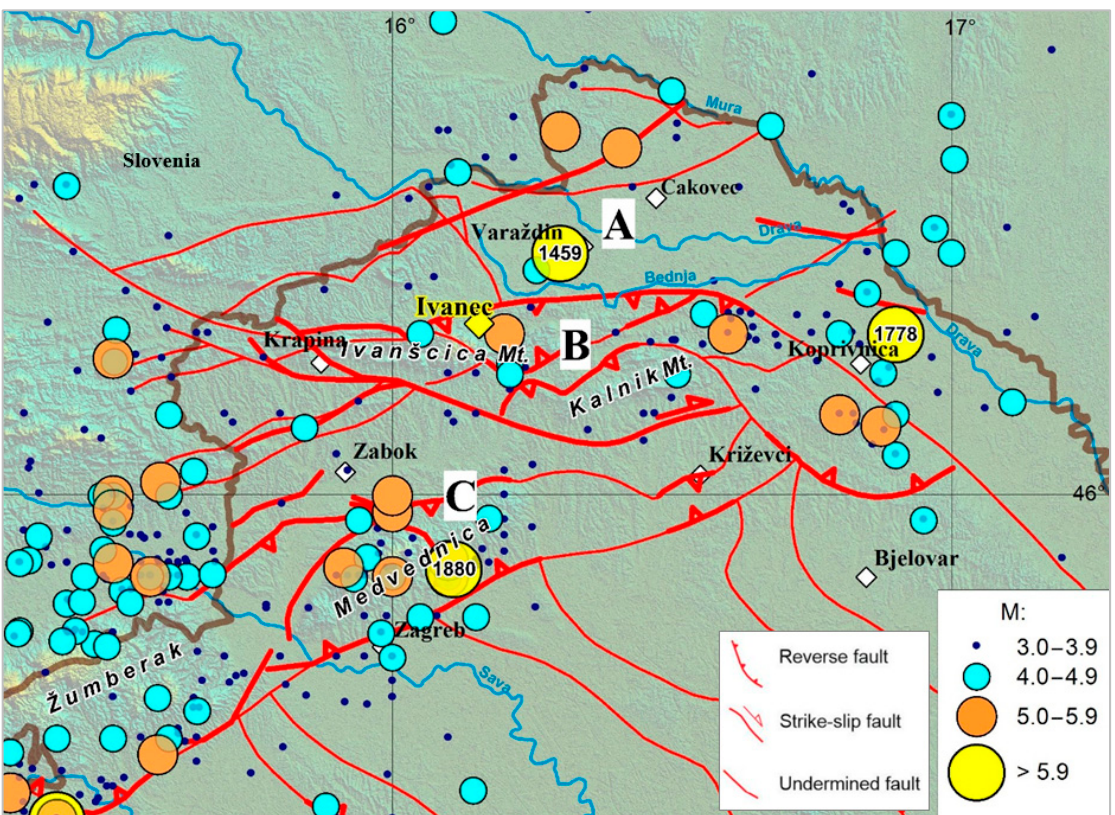
Figure 2. Epicentres of all earthquakes with M L ≥ 3.0 based on Croatian Earthquake Catalogue (373 BC to 2018) in the circle of approx. 50 km around the City of Ivanec (city location marked with yellow square). Most important seismogenic faults are shown with red lines are: (A) Drava fault, (B) Mt. Ivanš č ica and Mt. Kalnik North fault, (C) Medvednica fault [31,32].